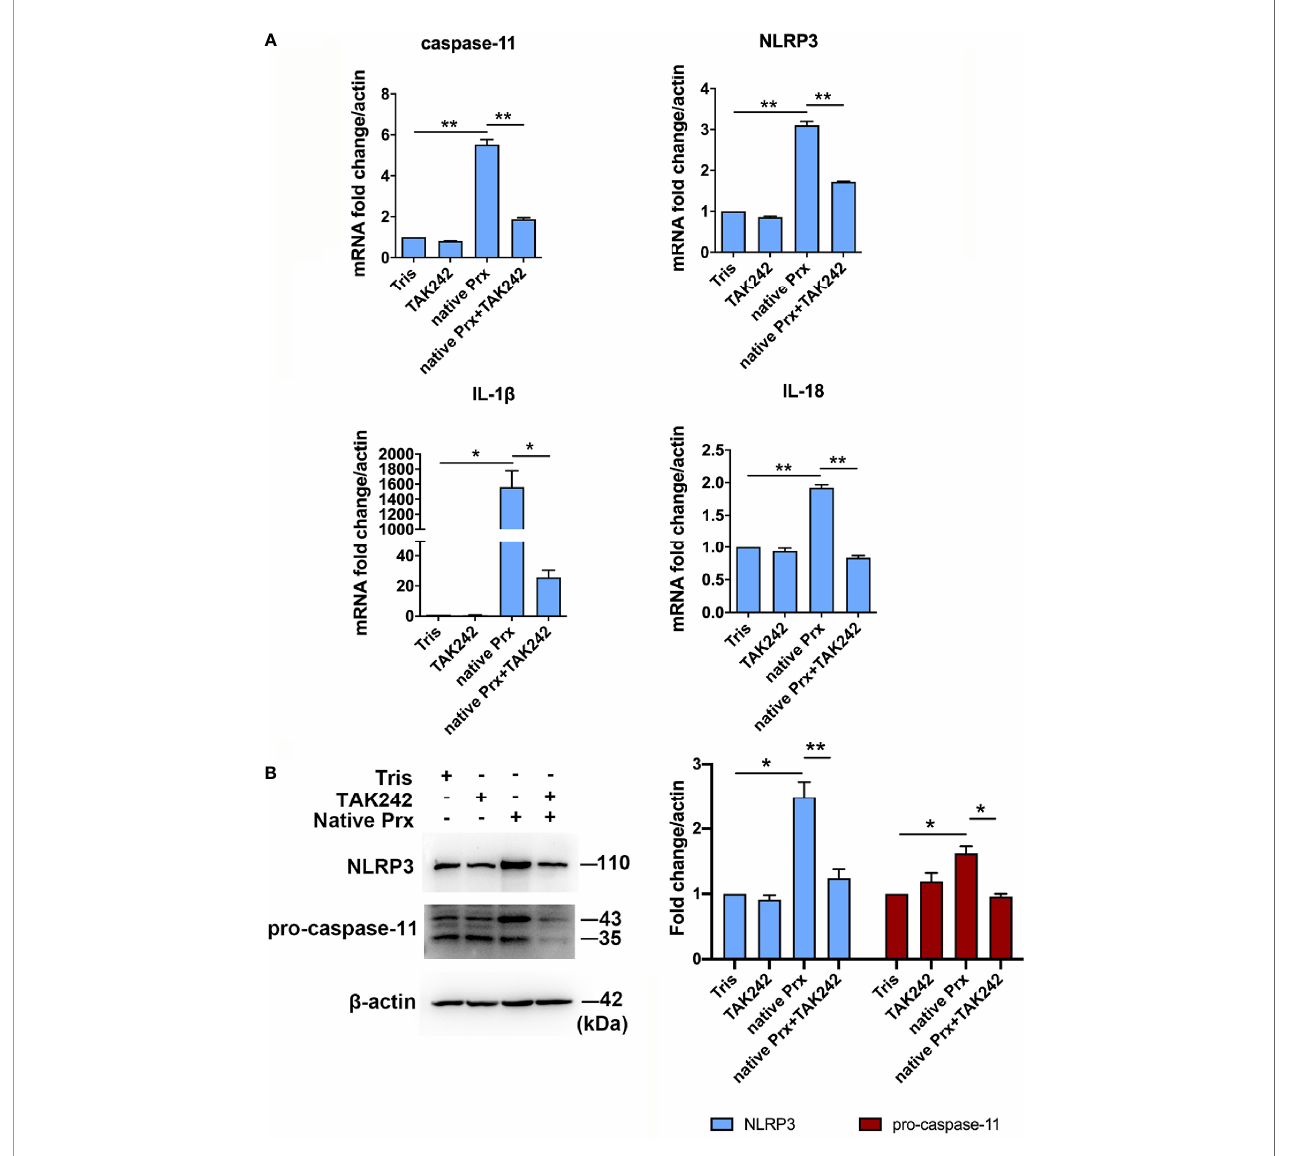
FIGURE 2 | Priming of NLRP3 in fl ammasome in macrophages by native Prx. (A) Gene expression levels detected by qPCR. RAW264.7 cells were treated with 5 m g/mL of native Prx, while LPS (1 m g/ml) and Tris-HCl (pH 8.0) was used as the control. Six hours after the treatment, the expression levels of related genes were measured by qPCR, and shown as 2- DD Ct of the target gene relative to b -actin, normalized with corresponding values. In all groups, n = 3. Experiments were repeated three times. (B) Western blot analysis of NLRP3 in fl ammasome-related proteins. RAW264.7 cells were pretreated with TAK242 (1 m M) for 1 h. Next, the cells were treated with either 5 m g/mL of native Prx or Tris-HCl (pH 8.0). Six hours after the treatment, the cells were collected, and the cell lysis was analyzed by western blotting. In all groups, n = 3. Experiments were repeated three times. Statistical analysis was conducted by Student ’ s t -test, and data are expressed as mean ± SEM. *p < 0.05, **p <